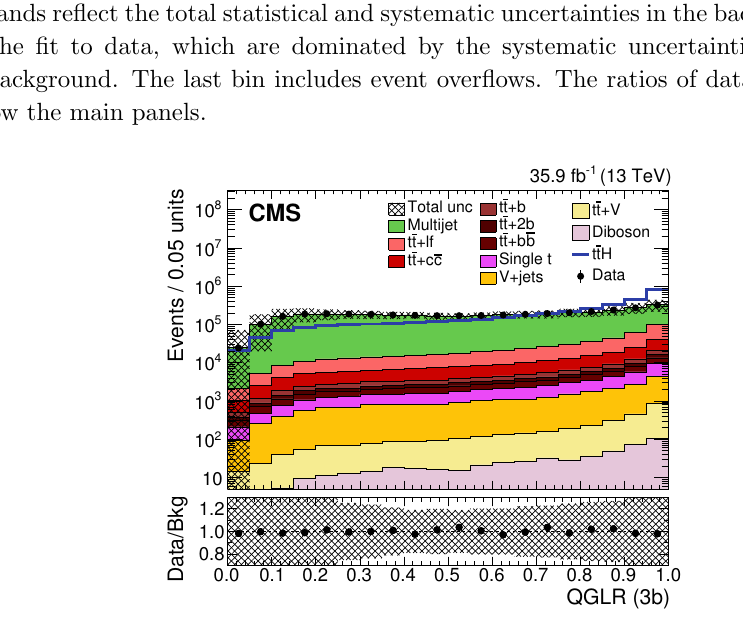
Figure 3 . Comparison of the distributions in the quark-gluon likelihood ratio in data (black points) and in simulation (stacked histograms), after preselection, excluding the (cid:12)rst 3 b-tagged jets. The simulated backgrounds are (cid:12)rst scaled to the integrated luminosity of the data, and then the simulated multijet background is rescaled to match the yield in data. The contribution from signal (blue line) is scaled to the total background yield (equivalent to the yield in data) to enhance readability. The hatched bands re(cid:13)ect the total statistical and systematic uncertainties in the background prediction, prior to the (cid:12)t to data, which are dominated by the systematic uncertainties in the simulated multijet background. The ratio of data to background is given below the main